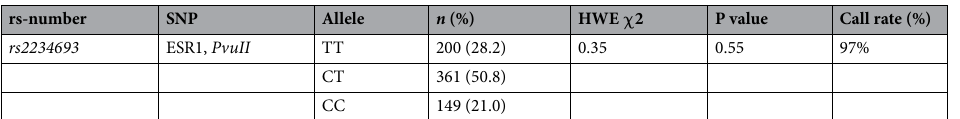
Table 1. Allelic frequencies of genotyped SNP. ESR1, estrogen receptor-1; SNP, single nucleotide